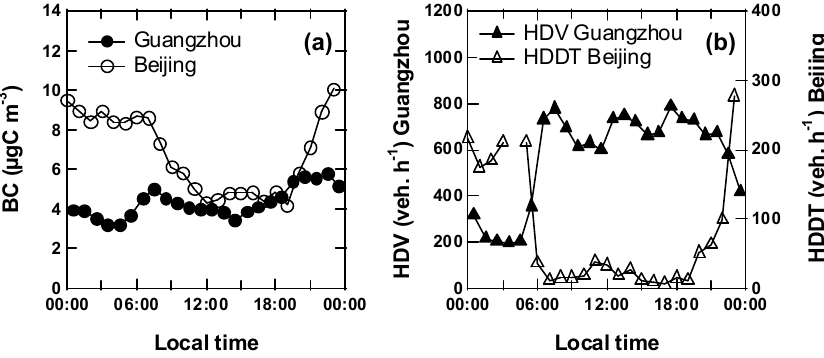
Fig. 9. Diurnal variations of (a) BC and (b) heavy-duty vehicles (HDV) in Guangzhou and heavy-duty diesel trucks (HDDT) in Beijing. The traffic volume of HDV includes buses and trucks, while HDDT is heavy-duty diesel trucks.